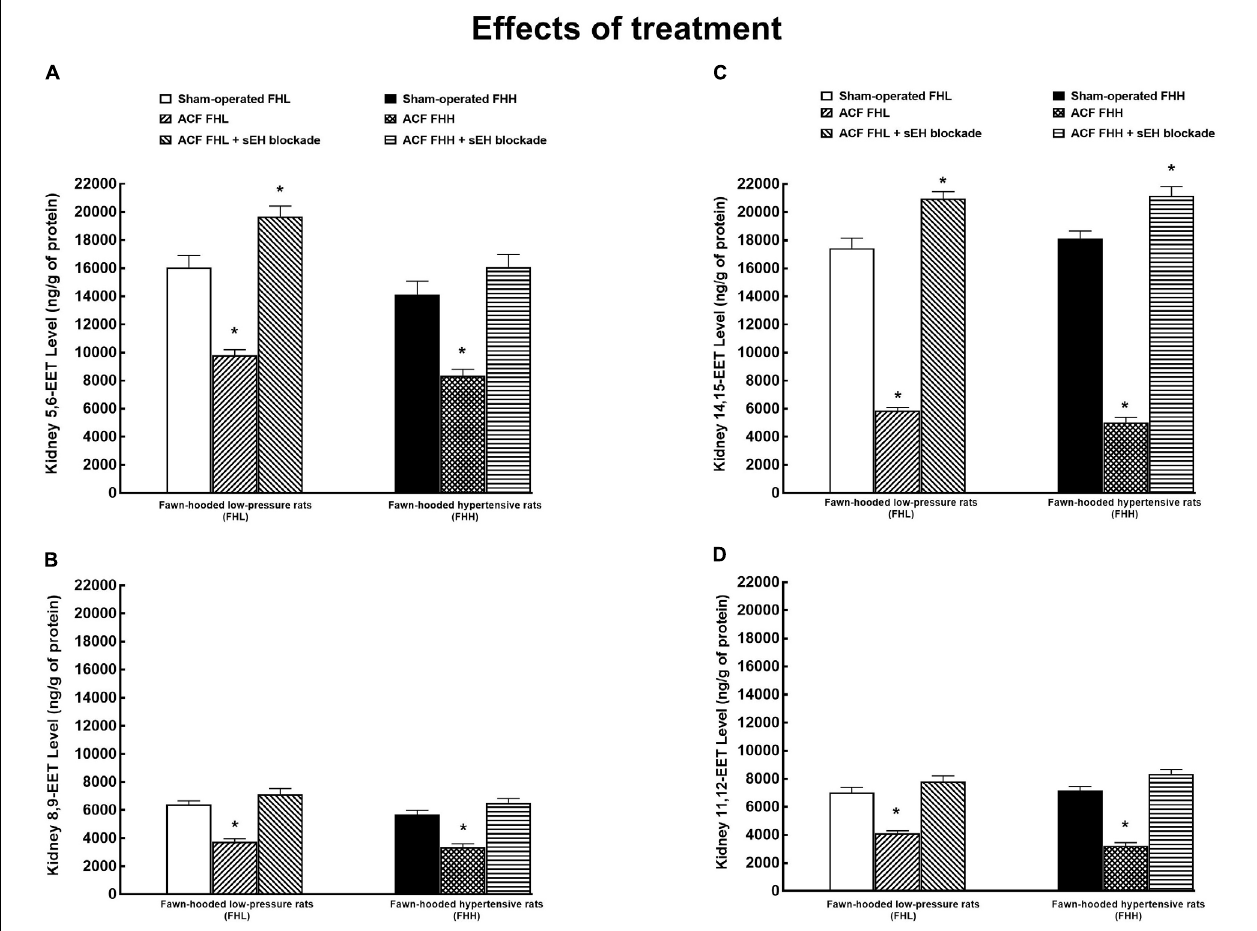
FIGURE 8 | Renal tissue 5,6-epoxyeicosatrienoic acid (EET) (A) , 8,9-EET (B) , 14,15-EET (C) , and renal 11,12-EET (D) concentrations in FHL and hypertensive (FHH) rats. The data for the groups of either strain that were sham-operated or with ACF or ACF rats treated with a sEH inhibitor. ∗ P < 0.05 compared with sham-operated